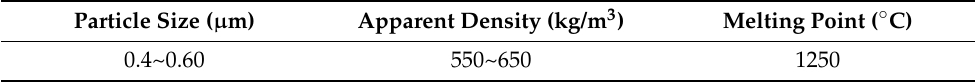
Table 5. Physical properties of micro-silica.